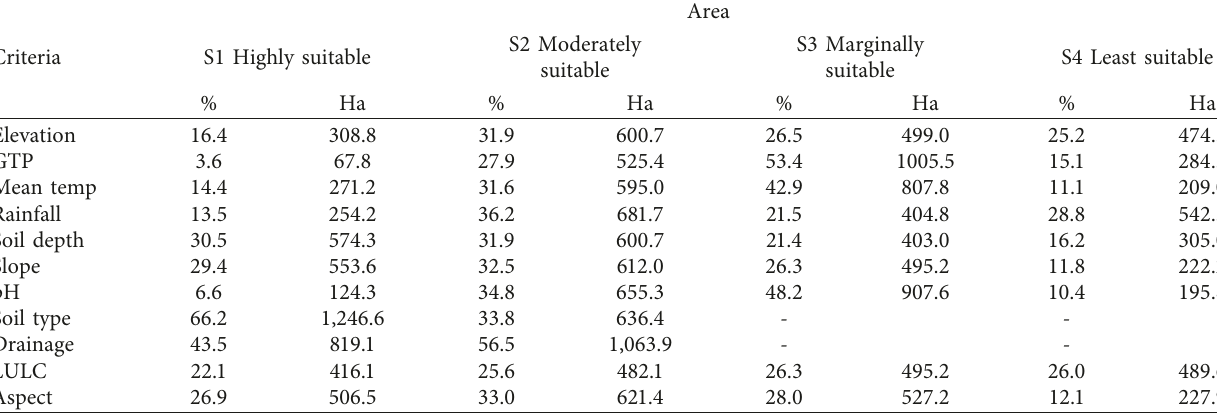
Table 5: Evaluation criteria and land area under different land suitability classes.